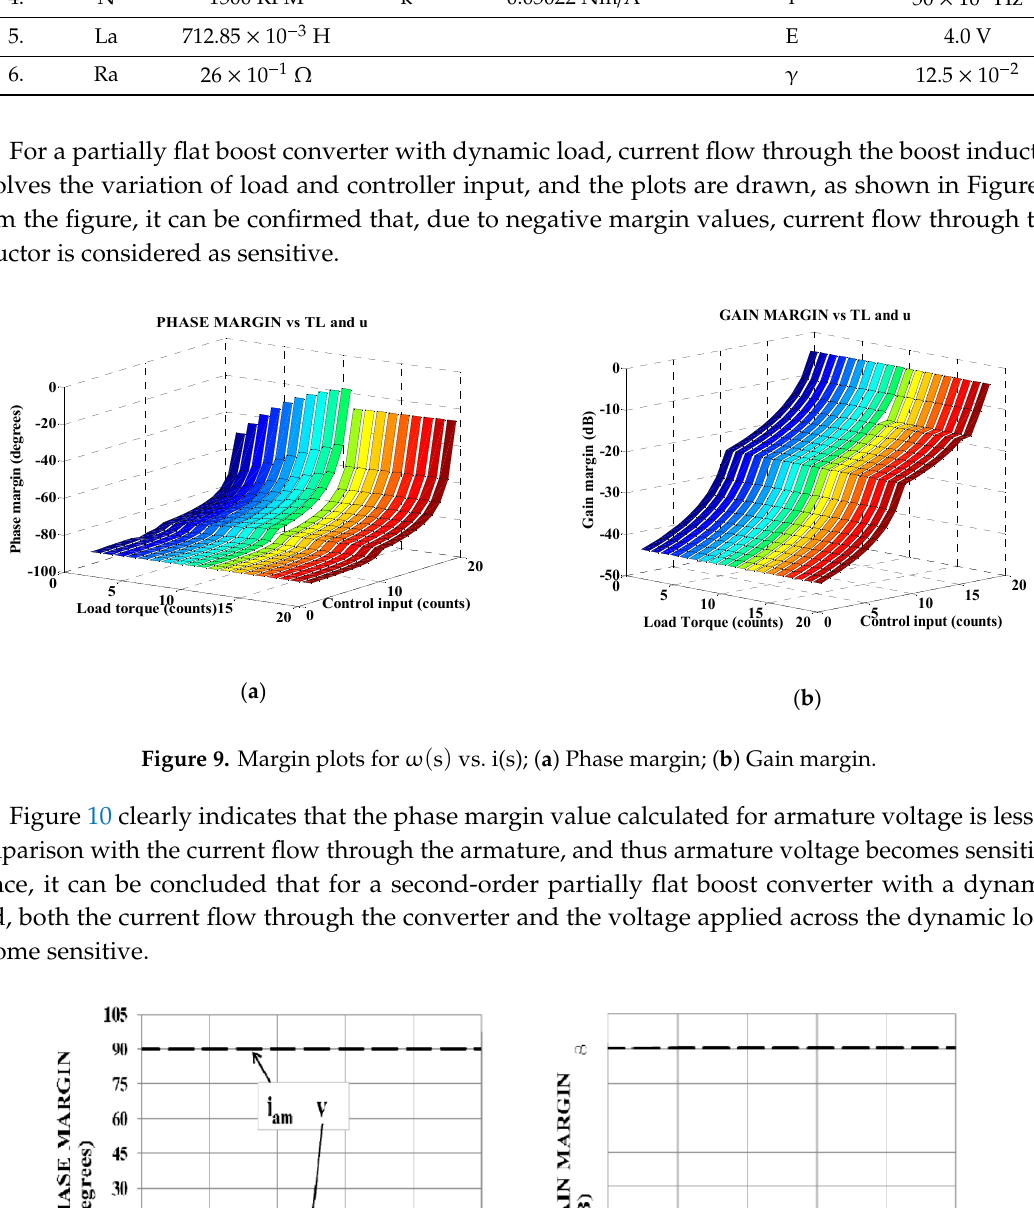
Figure 10. Sensitivity analysis of v and i am .( a ). Phase margin ( b ). Gain margin (both v and i am ).